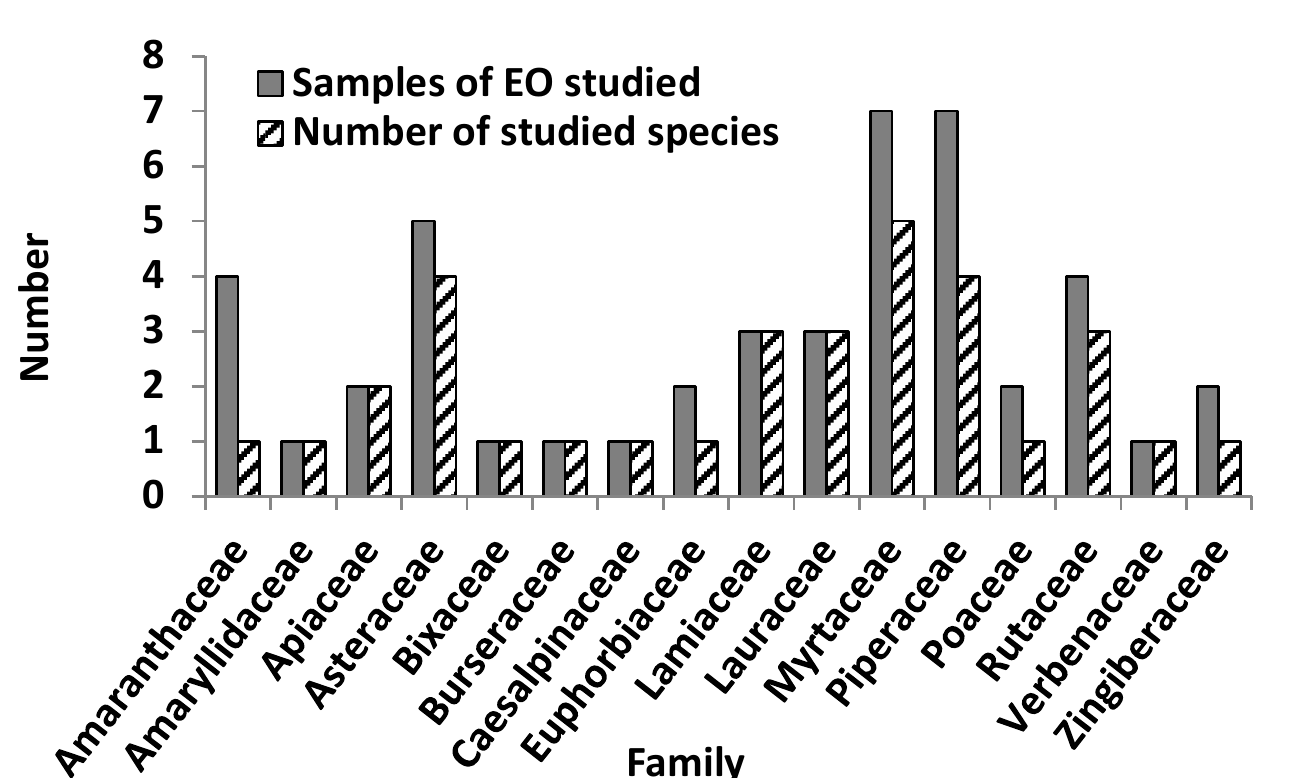
Figure 3. Samples and studies of essential oils from Cuban plants included in this study according to family. Table 2. Main characteristics of Cuban plants investigated in publications included in this review.